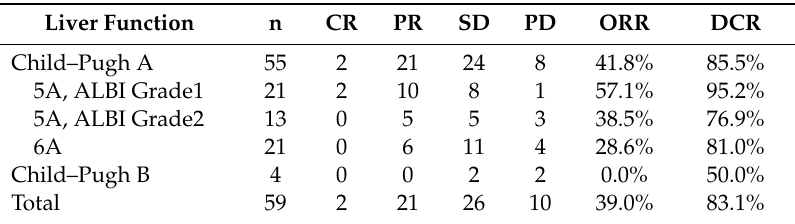
Table 2. Objective response rate (n = 59).